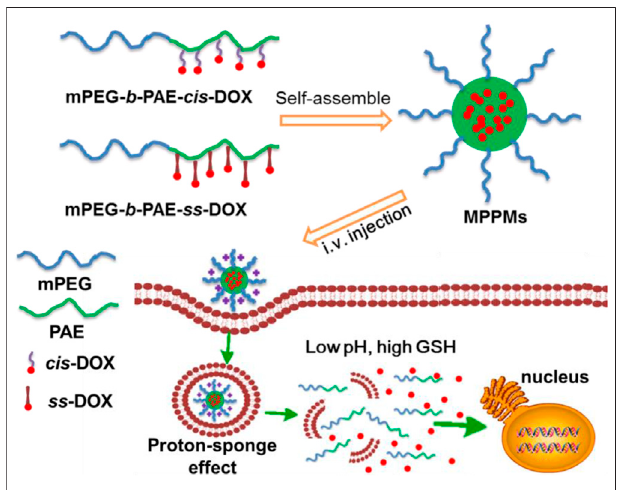
FIGURE 1 | Schematic diagrams of co-micellization of pH/redox dual- responsive polyprodrugs mPEG- b -PAE- cis -DOX and mPEG- b -PAE- ss -DOX in an aqueous medium and drug release triggered by acidic pH and high glutathione (GSH) level for cancer